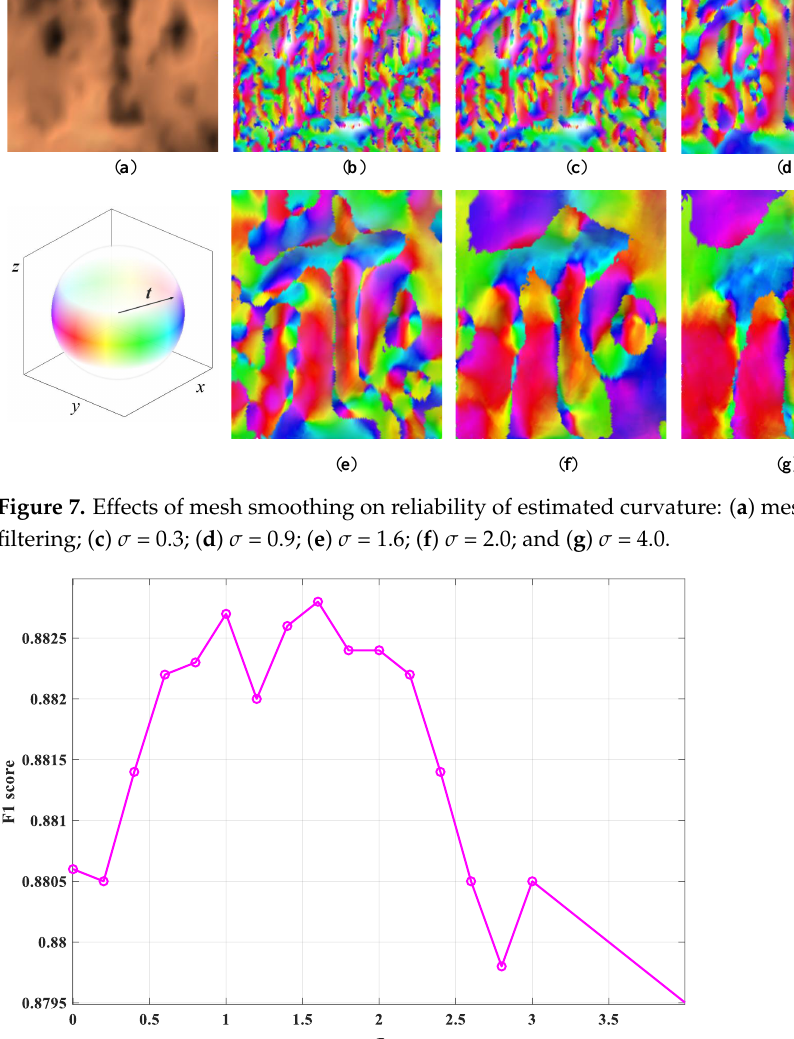
Figure 8. Performance of RF models (in terms of F1 score) under different σ